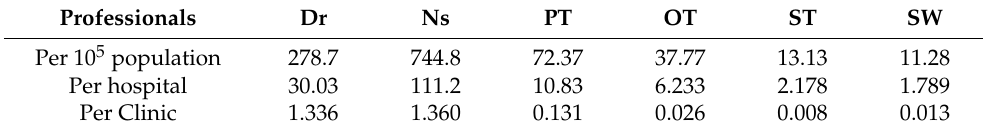
Table 1. Average numbers of professionals per 100,000 population, hospital, and clinic in Japan.